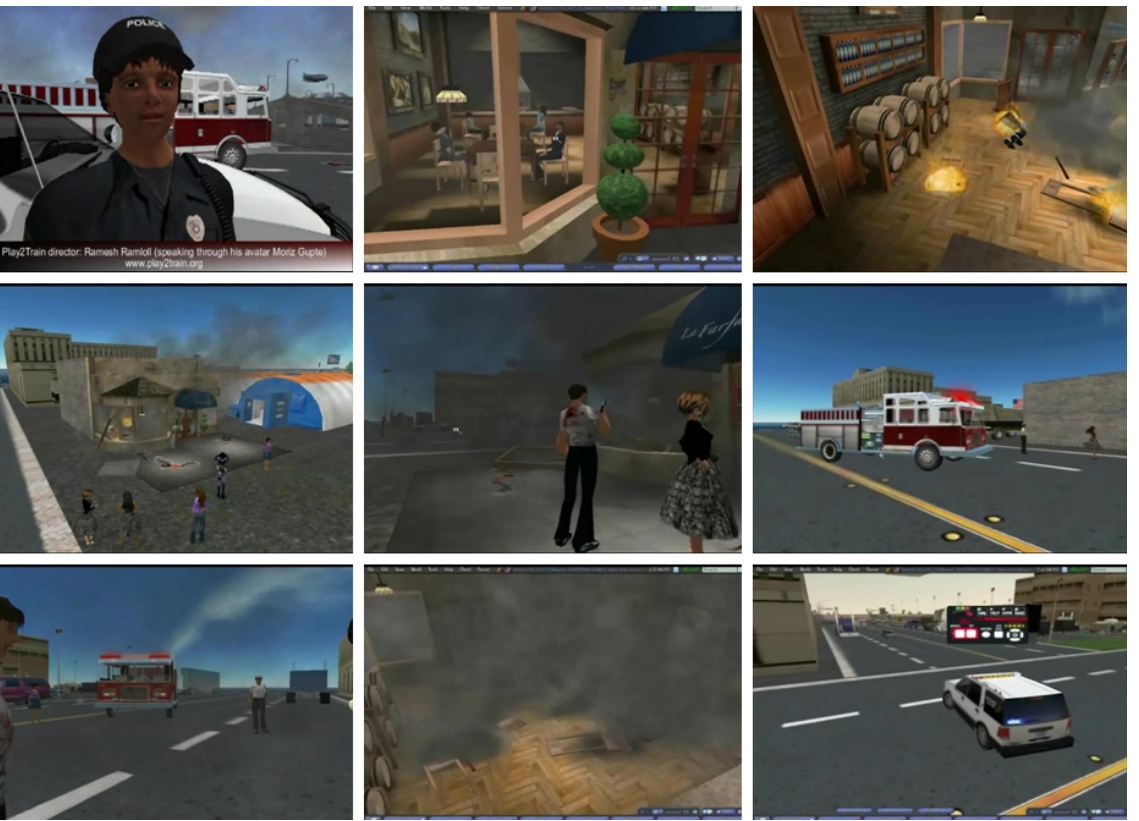
Figure 1. A mass casualty incident simulation to support the learning goals of a CERC